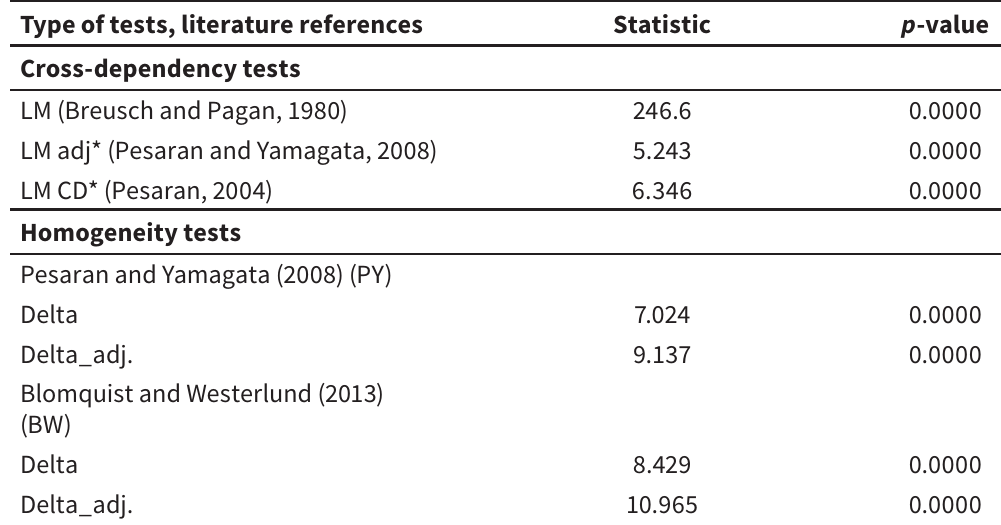
Cross-sectional dependence and homogeneity tests – full sample Type of tests, literature references Statistic p -value Cross-dependency